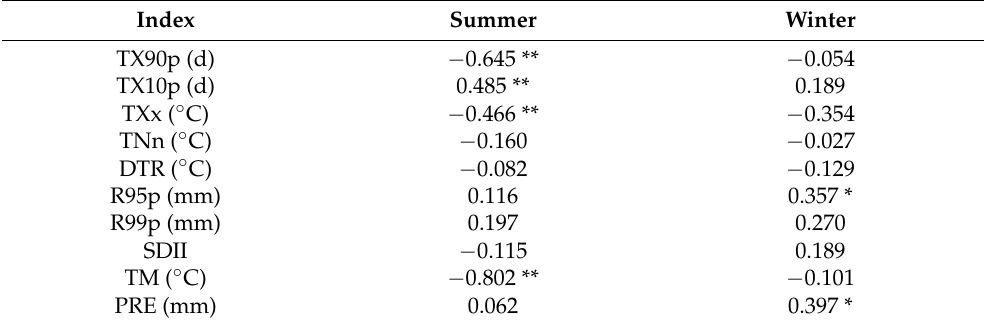
Table 4. Correlation between mass balance of Urumqi Glacier No.1 in different seasons and extreme climate